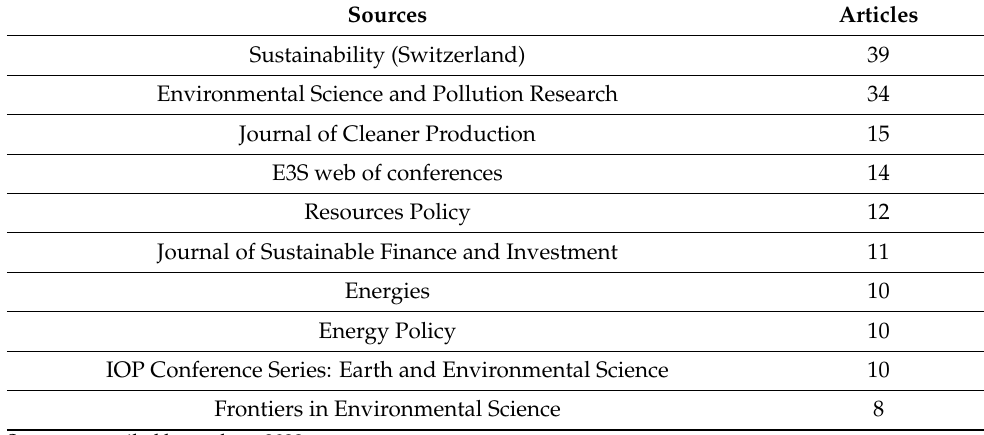
Table 8. Major journals contributing to green